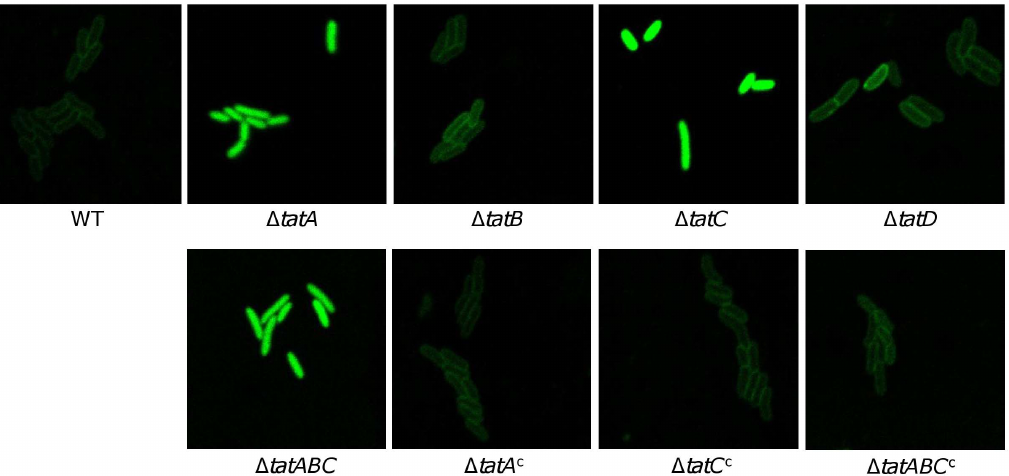
Figure 3. S.oneidensis Tat system recognizes E.coli Tat signal peptide. Fluorescence images of the wild type, tat mutant and their complemented strains carrying IPTG-inducible plasmid expressing hybrid protein TorA Ec -GFP (the signal peptide from the E. coli TorA fused to GFP). Cells at exponential phase ( , 0.4 of OD 600 ) were induced by 0.1 mM IPTG for 2 hours, and then sampled and visualized under a Zeiss LSM-510 confocal laser scanning microscope. The images were taken 1 h after the end of